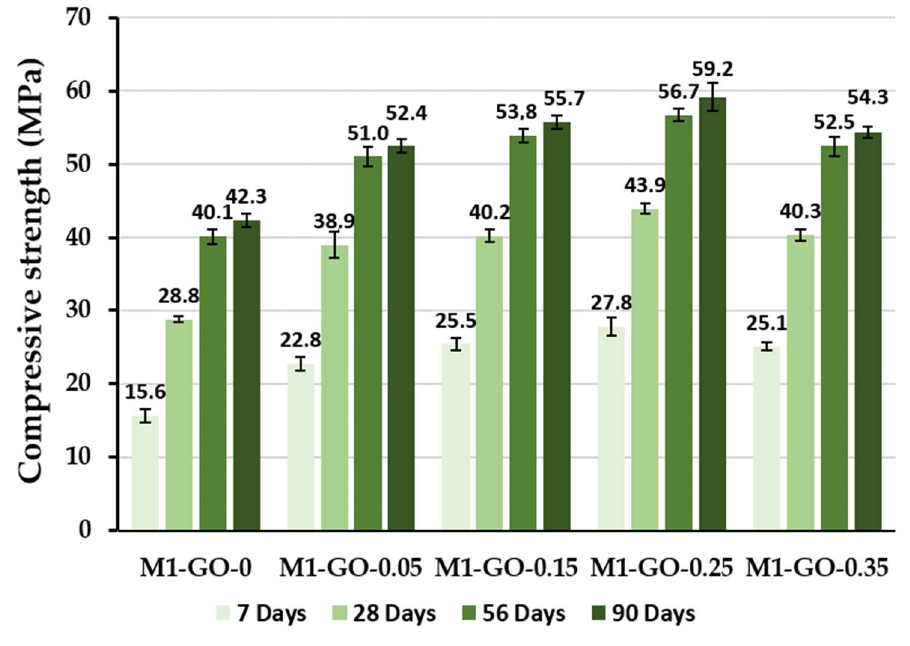
Figure 4. Compressive strength of M1 mix (FA85-G15).